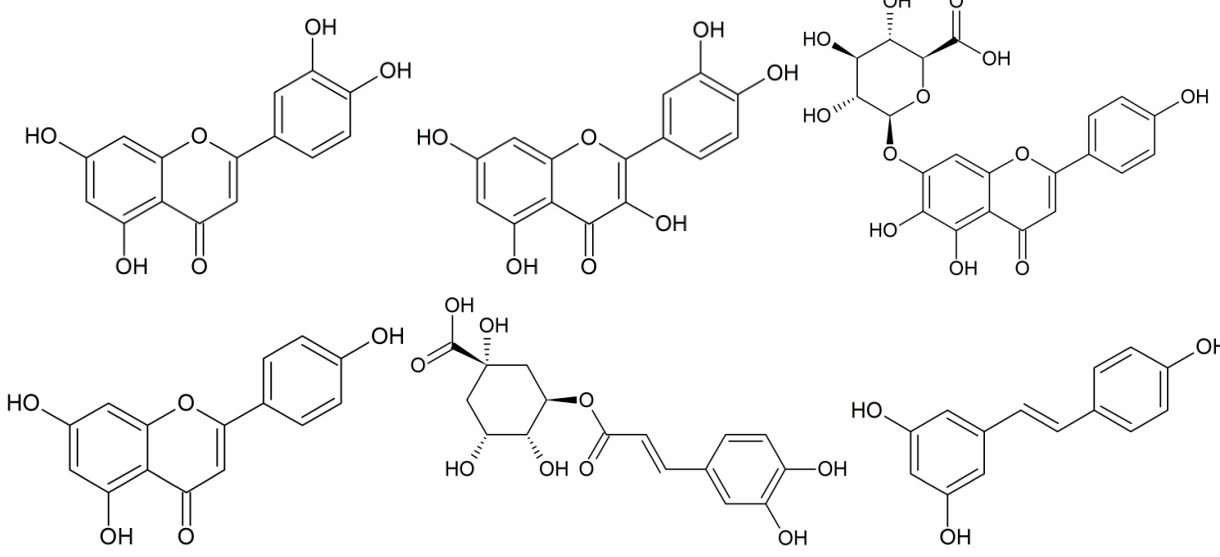
Figure 1. Molecular structures of the six flavonoids luteolin, quercetin, scutellarin, apigenin, chlorogenic acid and resveratrol.